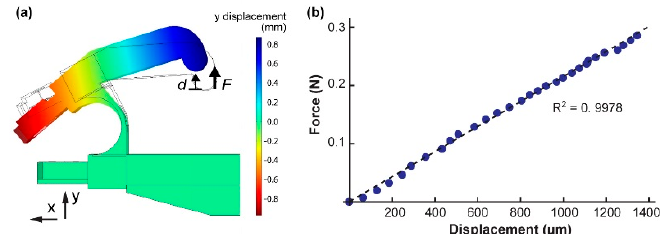
Figure 6. Once fundamental material properties are found, characteristics of an arbitrarily designed part can be found from a finite element method (FEM) analysis. ( a ) COMSOL ® analysis of the tweezer flexure. The image displays the cam with an applied force of 0.2 N. ( b ) Experimentally measured tweezer flexure force vs. displacement